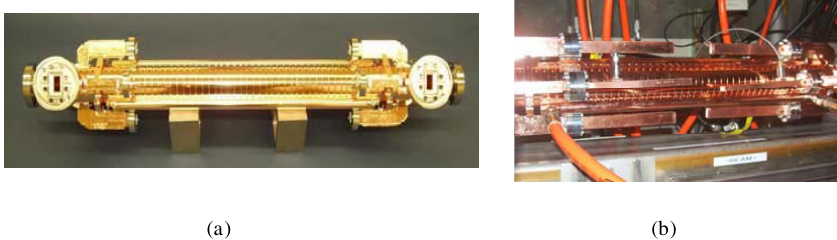
FIG. 9. (Color) Completed accelerating structure H60VG4SL17A (a) and (b) installed on an alignment strong-back in the ASSET facility of the